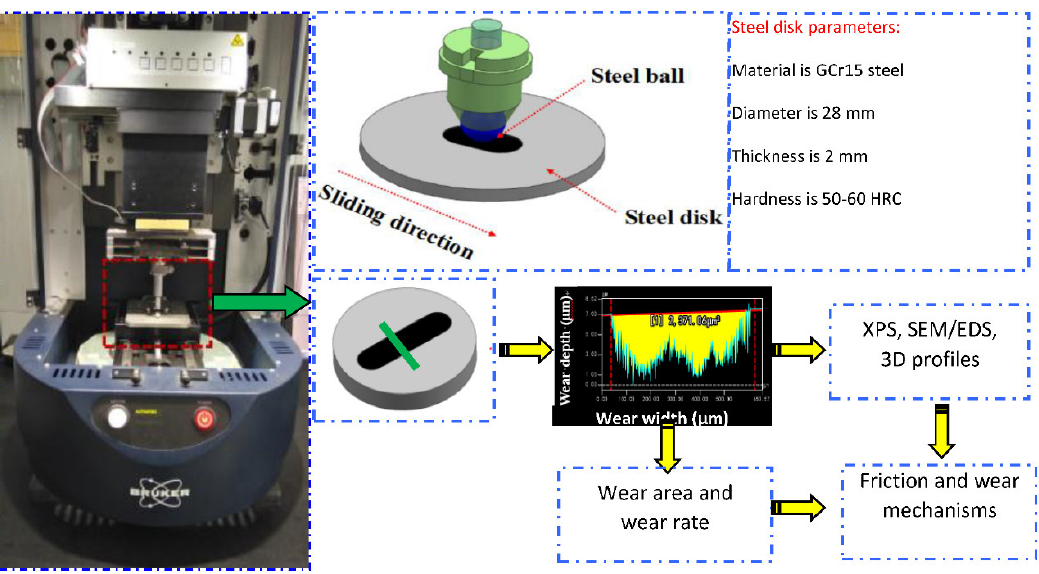
Figure 1. Schematic of the tribometer and analysis methods.